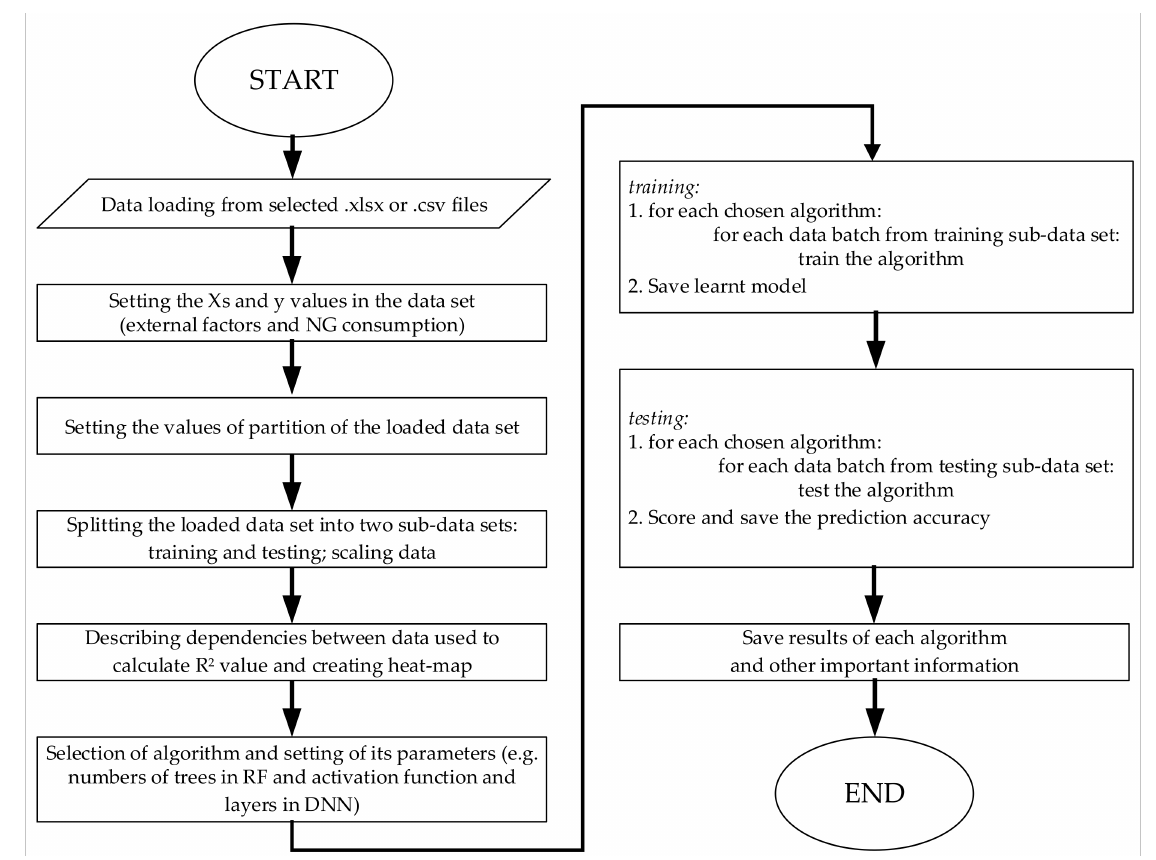
Figure 7. The simplified flowchart diagram of the model used in presented